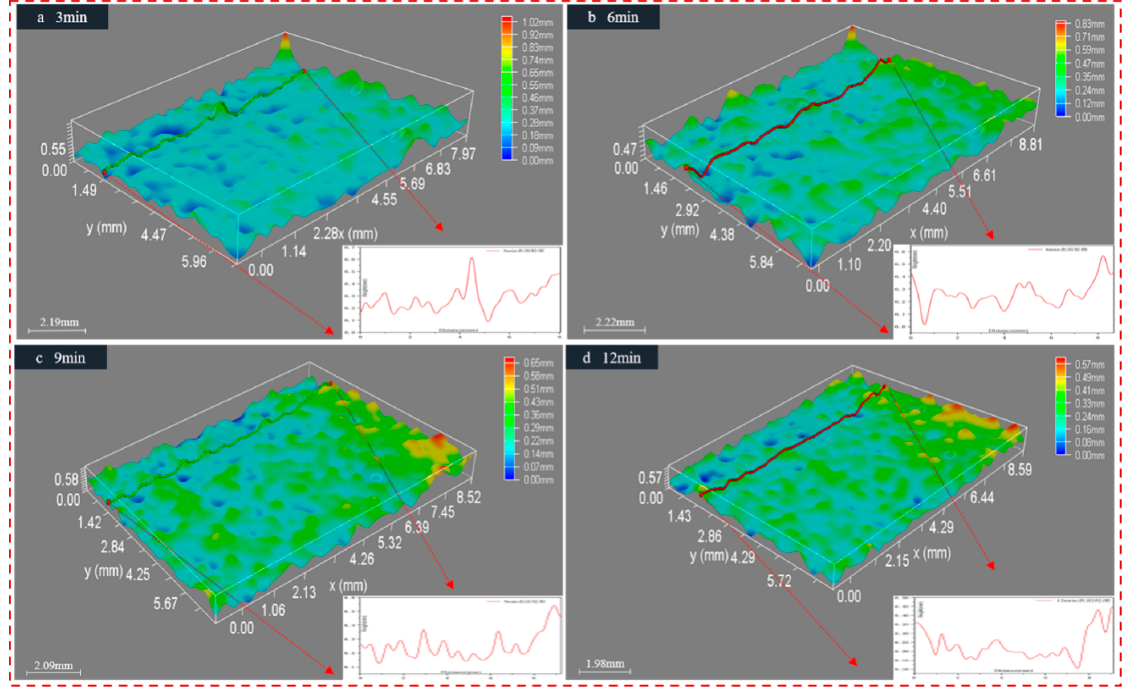
Figure 13. Surface profile of the abrasive grain position of the polishing pad after wear. ( a ) Wear for 3 min; ( b ) wear for 6 min; ( c ) wear for 9 min; and ( d ) wear for 12 min. 3 min; ( b ) wear for 6 min; ( c ) wear for 9 min; and ( d ) wear for 12 min.